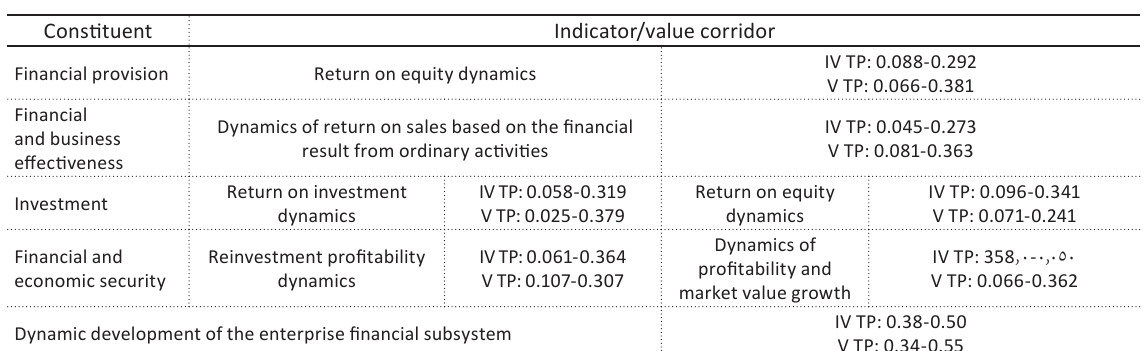
Table 3. Target values of development of the enterprise financial subsystem to form an effective project portfolio